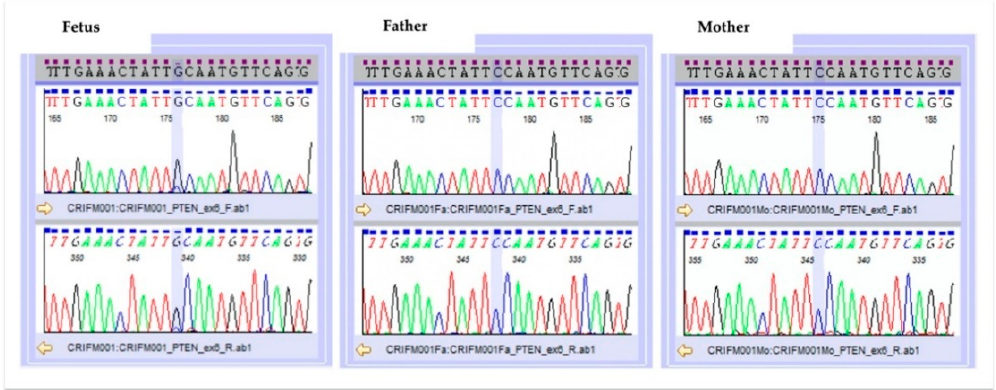
Figure 4. Result of Sanger sequencing.